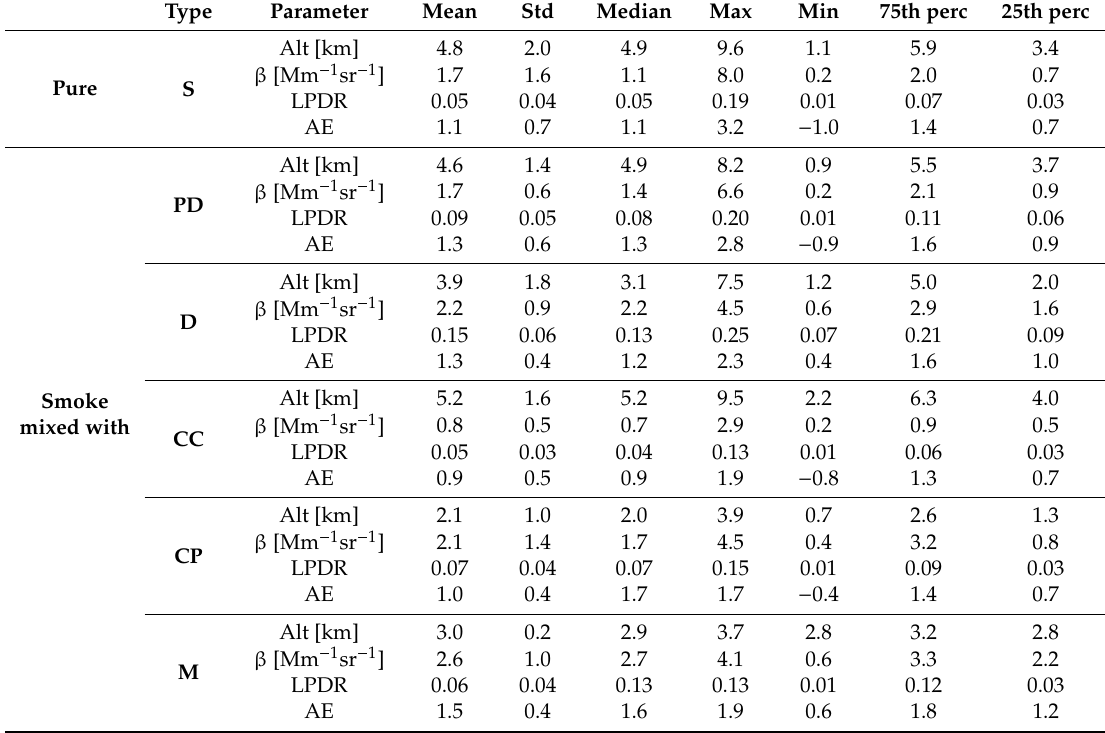
Table 1. Descriptive statistics of the altitude, β , LPDR and AE values for di ff erent aerosol types for the total event: mean, standard deviation (std), median, maximum value (max), minimum value (min), 75th and 25th percentile for all